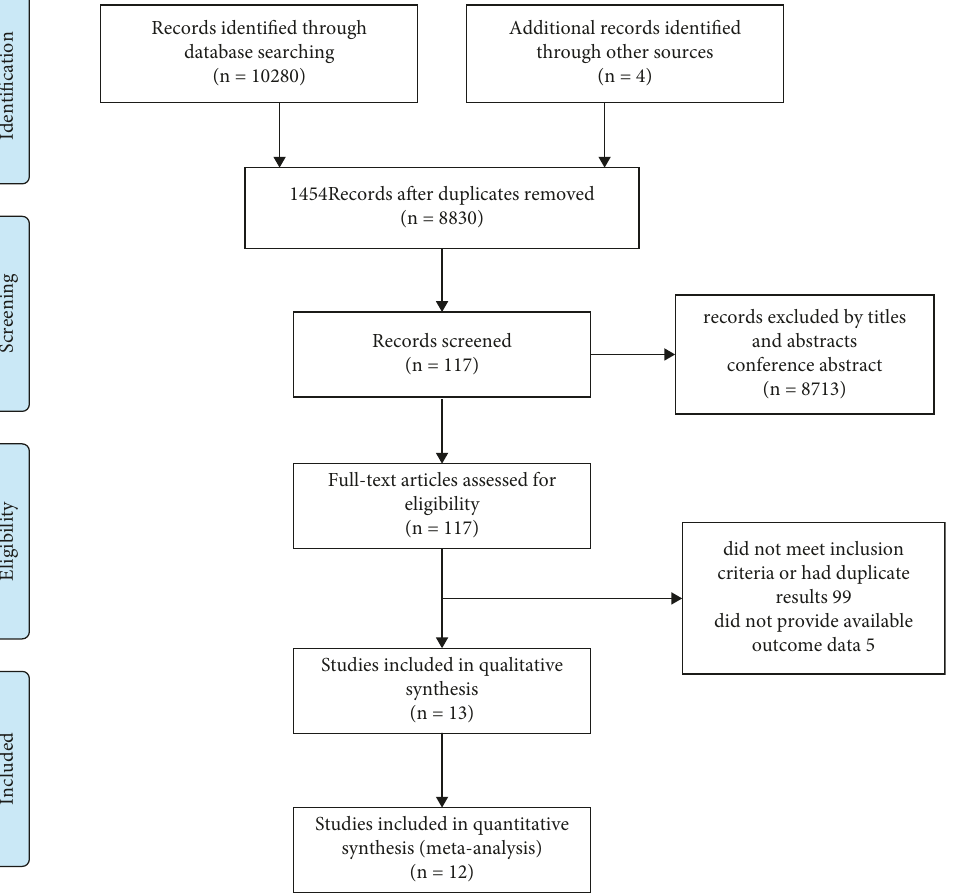
Figure 1: Flowchart for study inclusion.